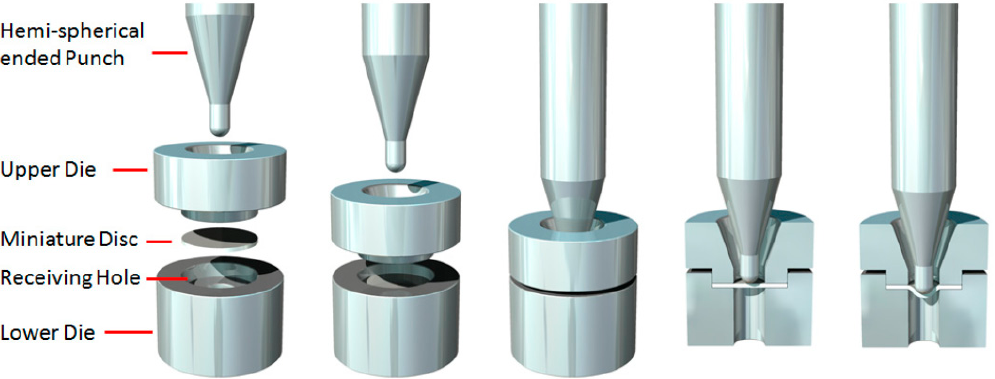
Figure 2. Illustration of the Small Punch test method including the assembly of the upper and lower die, miniature disc and hemi-spherical punch [9].